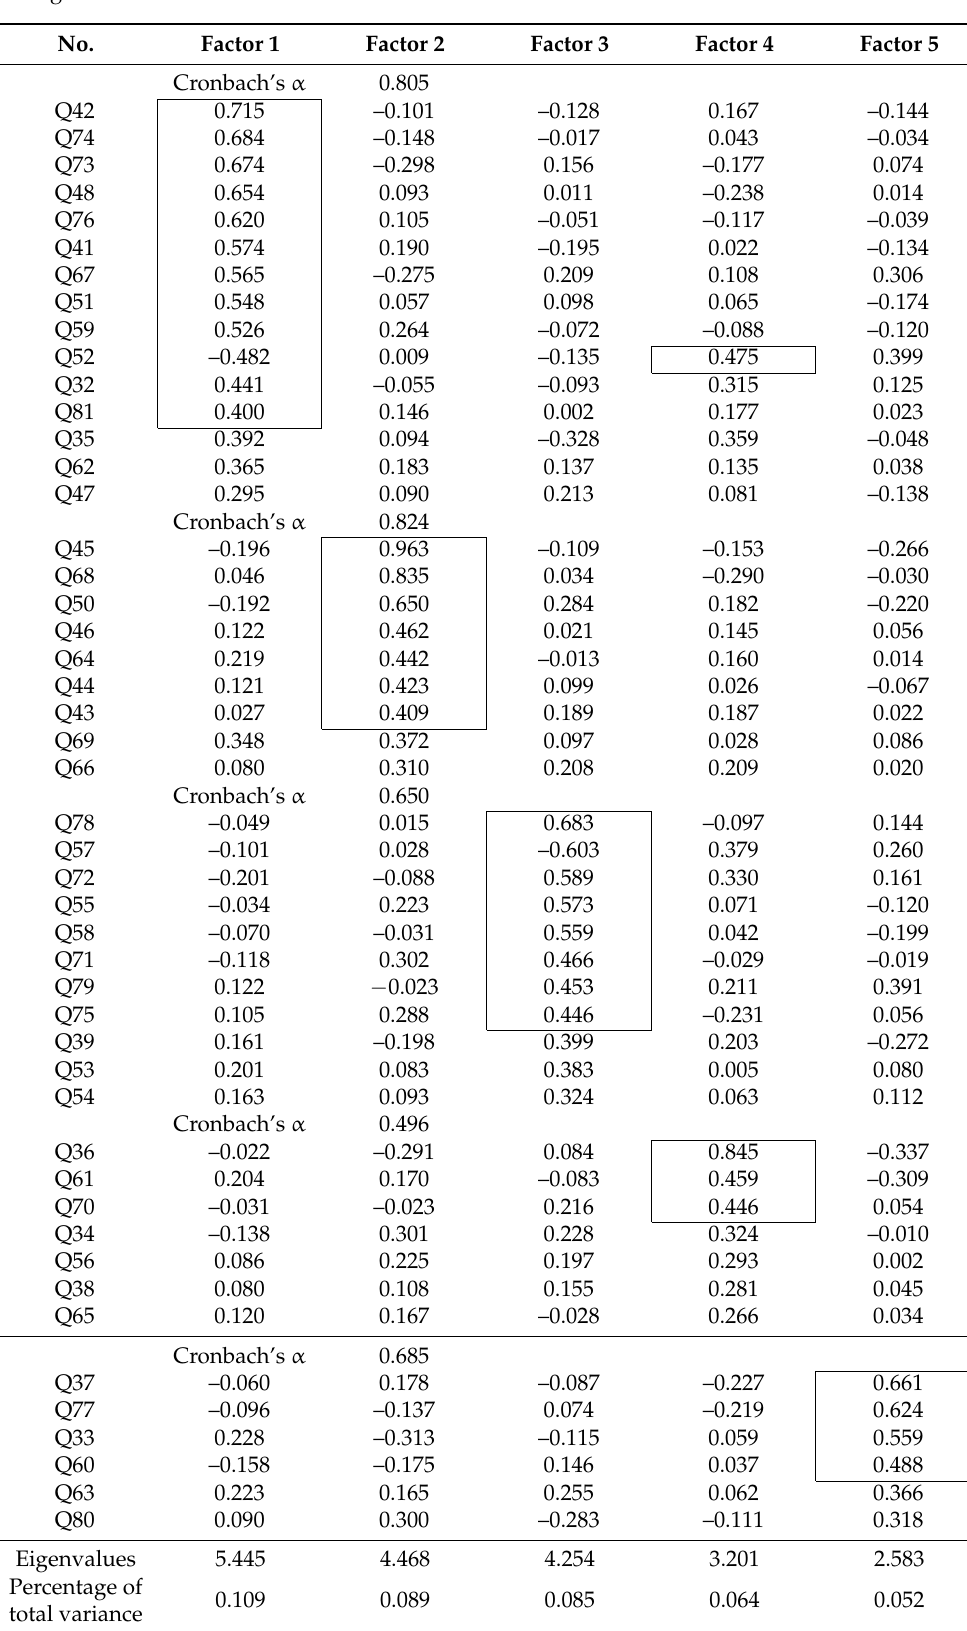
Table 4. Factor loadings and variance explained from an exploratory factor analysis of the Learning Strategies